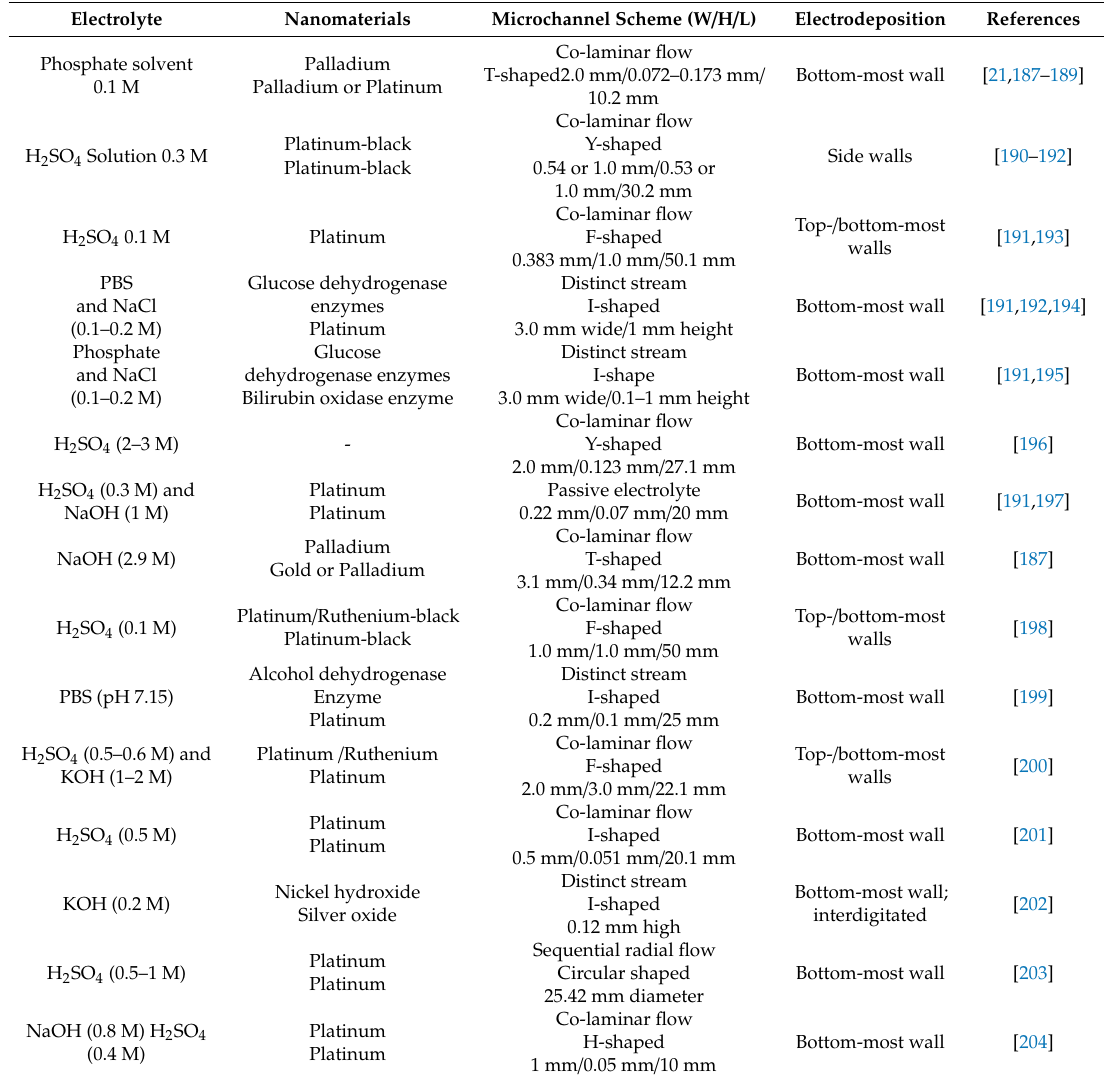
Table 4. Nanomaterials used in